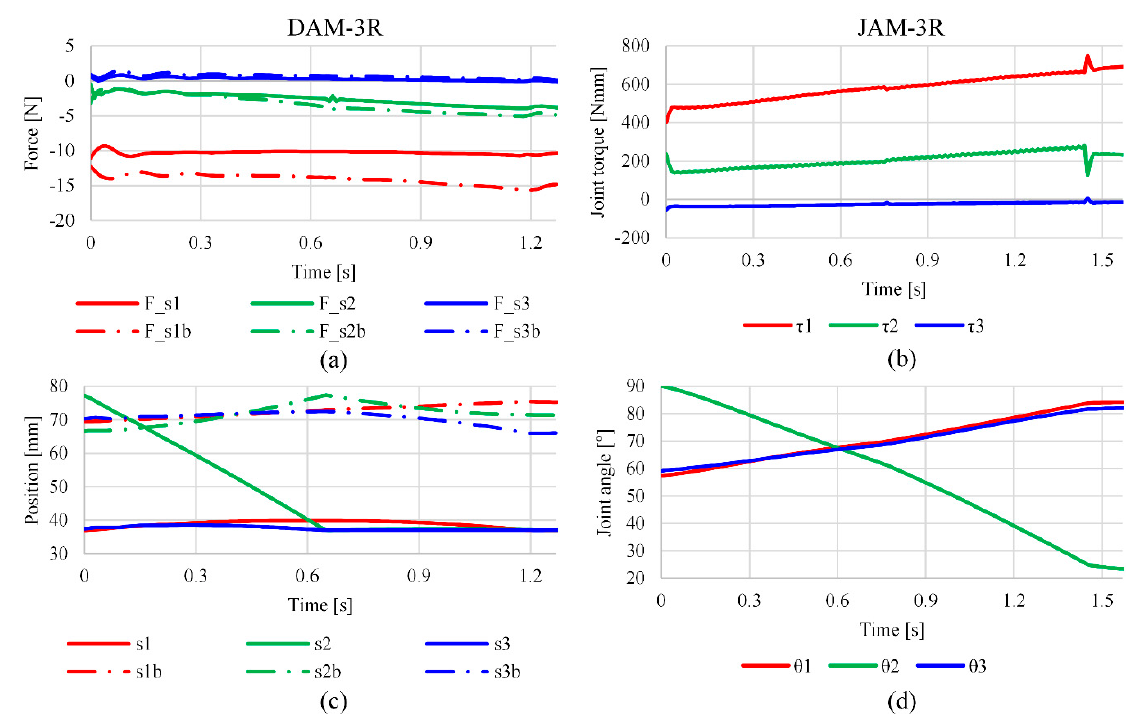
Figure 9. Simulation results regarding actuating forces and output motion in the joint space: ( a ) Actuating force results for the DAM-3R; ( b ) Actuating torque results for the JAM-3R; ( c ) Slider position results for the DAM-3R; ( d ) Joint angle results for the JAM-3R. Table 4. Energy consumption in the joint space for the DAM-3R and